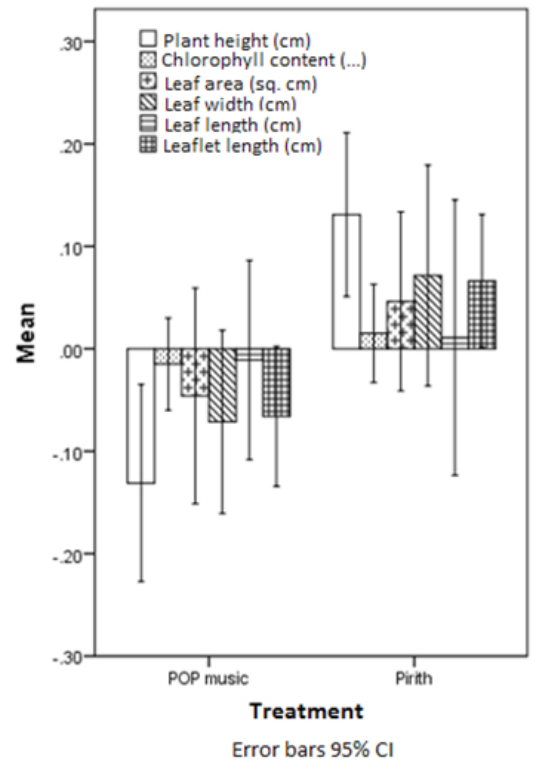
Figure 1: The percentage difference of the parameters compared to the control plant.